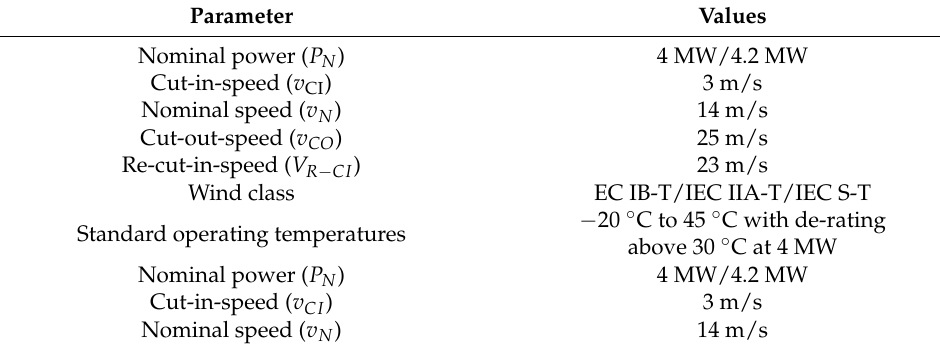
Table 2. Vestas V117-4.2 MW wind turbine operating